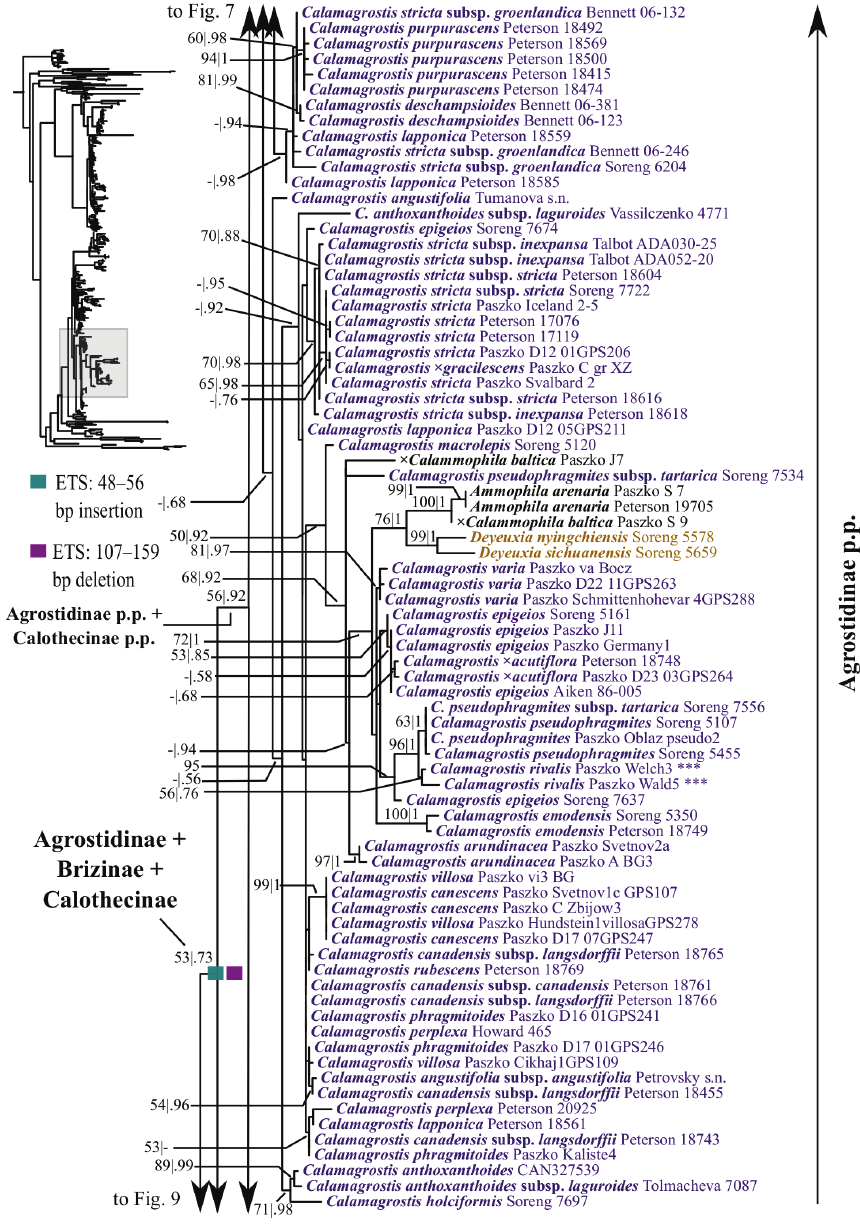
Figure 8. A portion (part of Agrostidinae p.p.) of the maximum likelihood phylogram inferred from ITS+ETS data. ML bootstrap support (left) and BI poster probabilities (right) are recorded along branch- es. A dash indicates bootstrap support <50%. No support is shown for branches with bootstrap support <50% and posterior probability <.5. The shaded area of the smaller tree on the upper left indicates the lo- cation in the overall tree of the portion shown. Placements of samples with asterisks (***) are incongruent in nrDNA and plastid trees. Two indels in ETS are mapped onto the